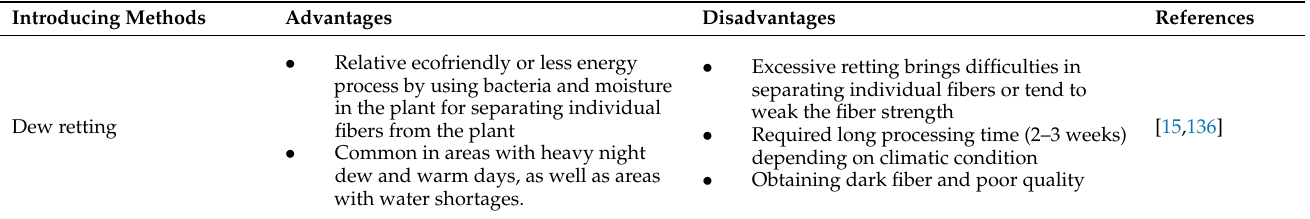
Table 1. Preparation method for producing the extracted natural bast fibers.